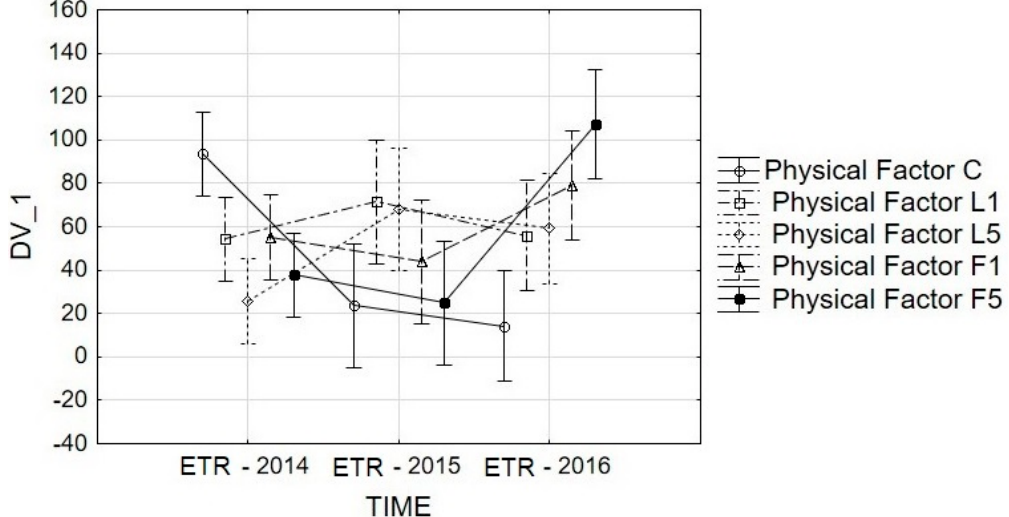
Figure 7. Repeated-measures ANOVA for ETR: interaction graphs for time and physical factor. Vertical bars denote 0.95 confidence intervals. Estimated Marginal Means: TIME*Physical Factor. F(8,270) = 6.8785, p = 0.00. C—control; L1—He–Ne laser, exposition time 1 min; L5—He–Ne laser, exposition time 5 min; P1—alternating magnetic field, exposition time 1 min; P5—alternating magnetic